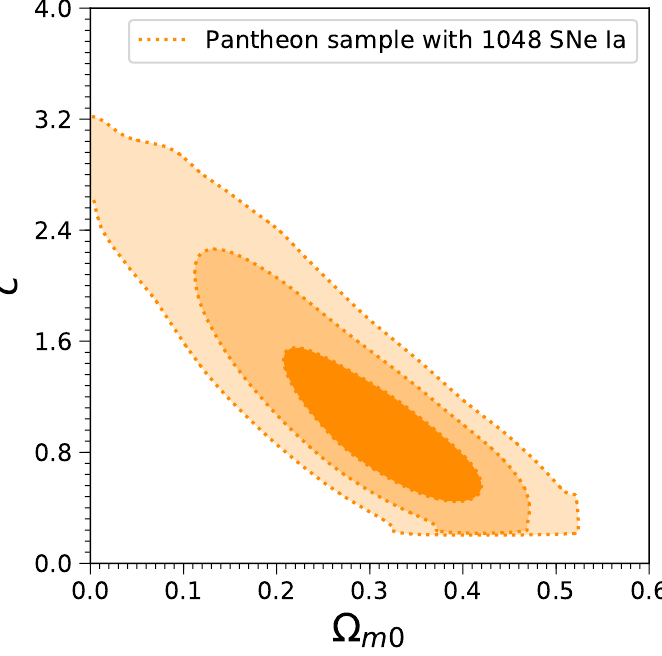
Figure 8. Confidence intervals at 68% ,95% and 99% in the ( Ω m0 , c ) plane constrained from the Pantheon SNe Ia sample including 1048 SNe Ia with 0.01 < z < 2.3.